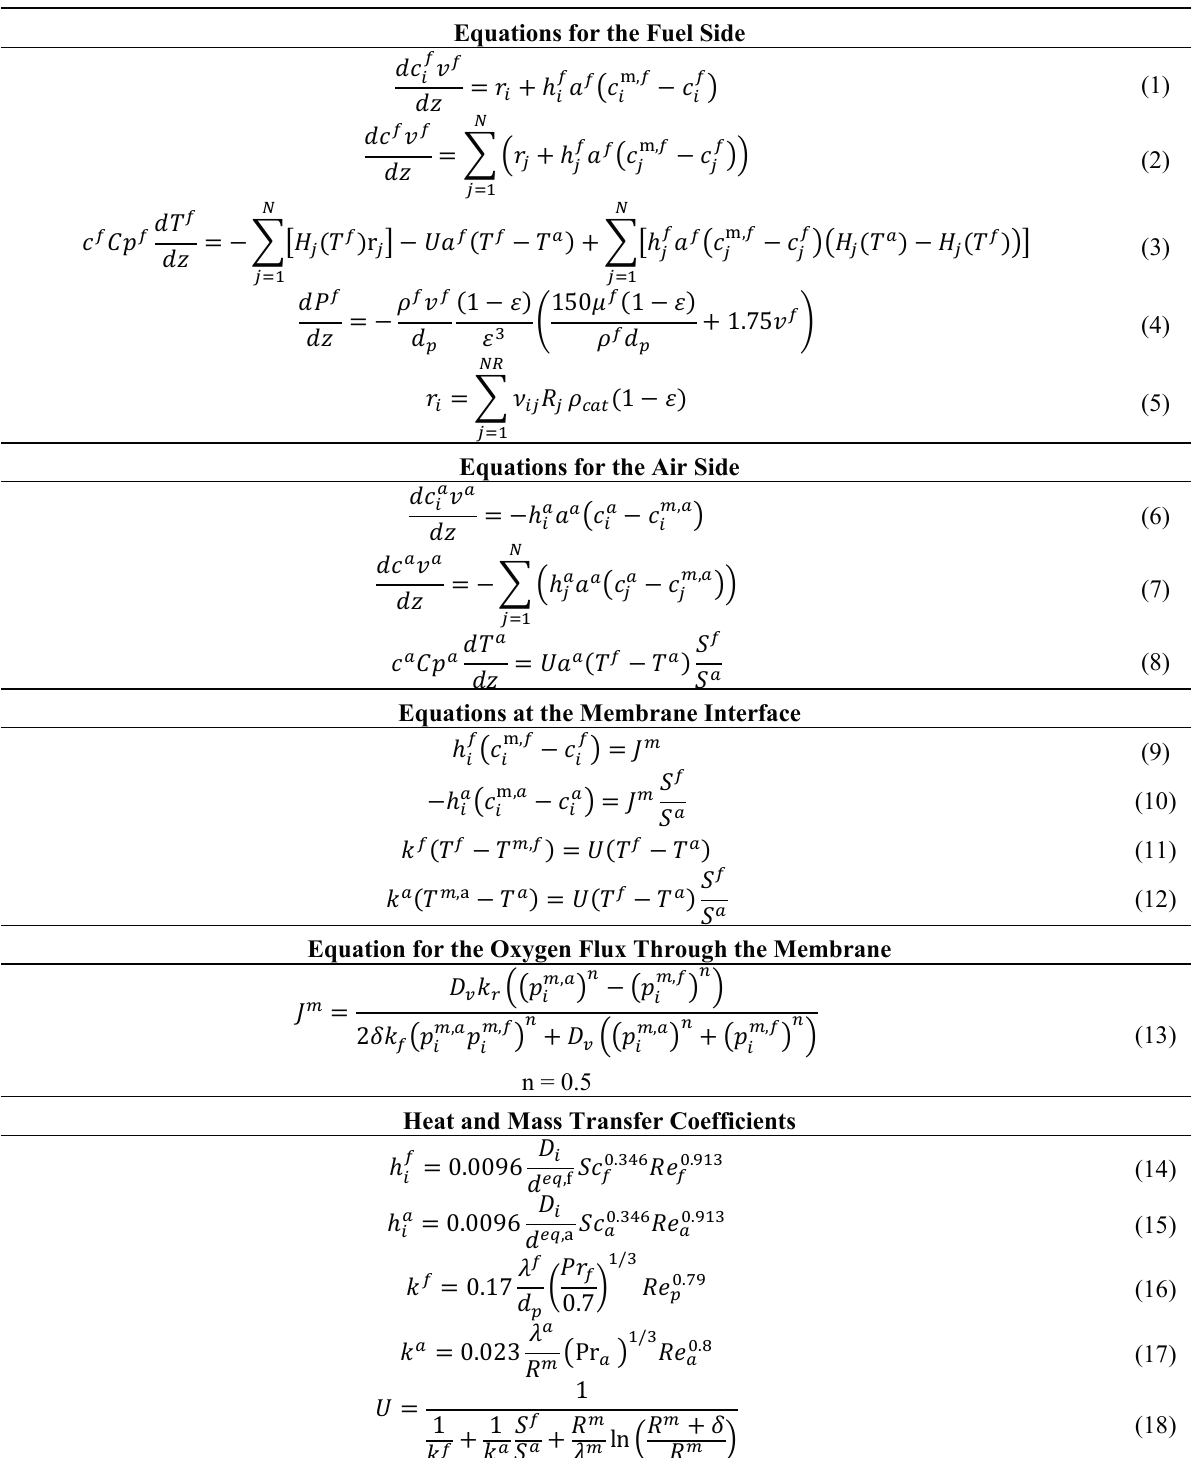
Table 1. Equations for the membrane reactor